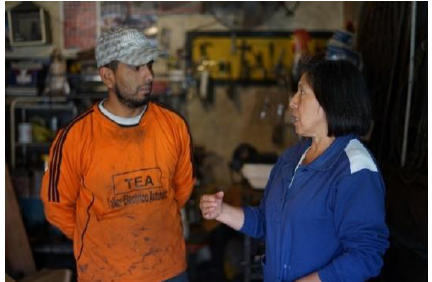
Figure 2. Luz Naula on the day the maintenance campaign interventions finished. Source: Carolina Martinez, 2018.